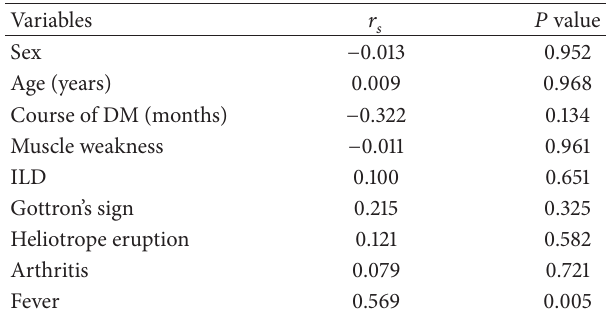
Table 2: Correlation between IL-6 and clinical features in patients with DM.